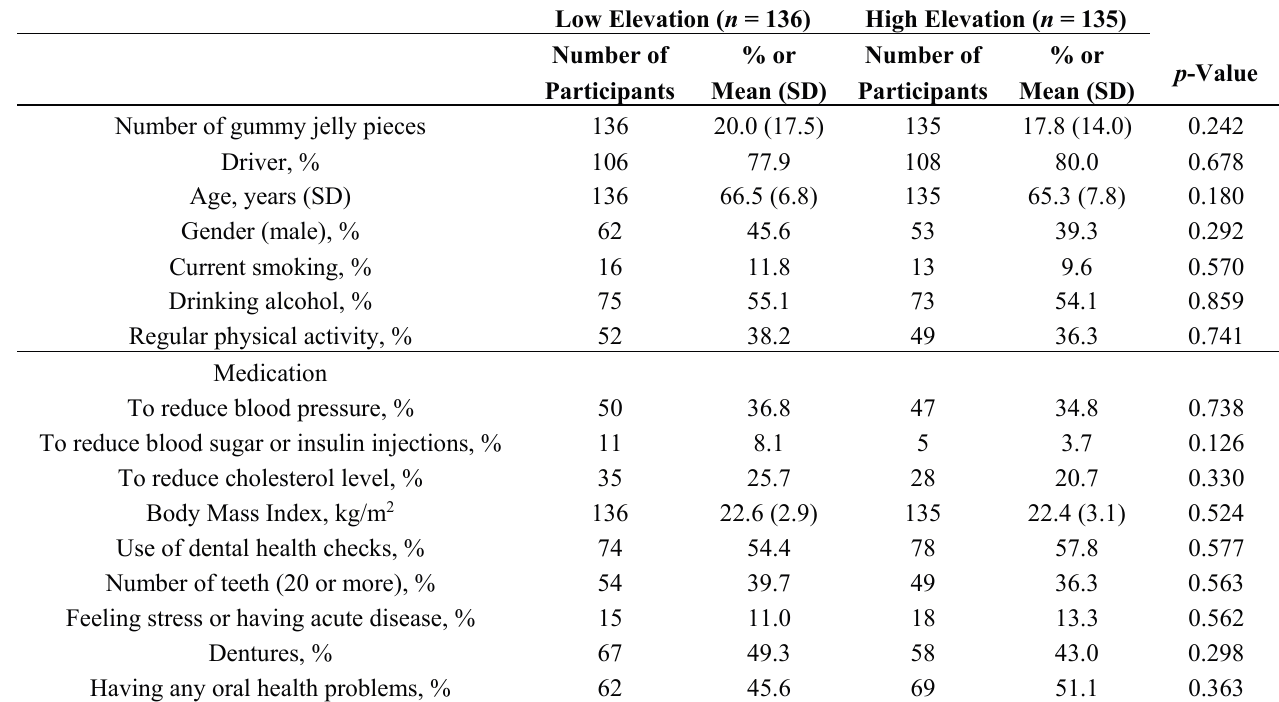
Table 1. Characteristics of the study participants in Mizuho